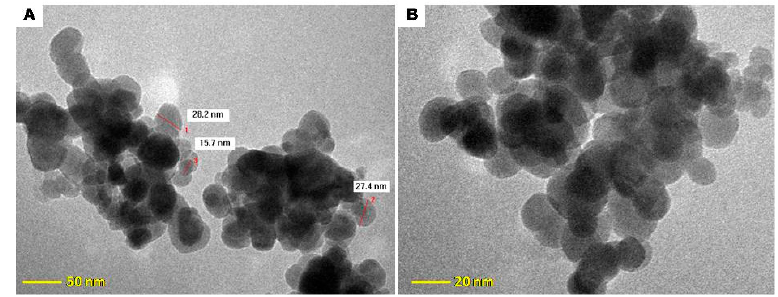
Figure 6. TEM micrograph of Fe 3 O 4 @C matrix. ( A ) magnification 220 Kx; ( B ) magnification 300 Kx. Table 1. Elemental composition of the Fe 3 O 4 @C matrix. Element